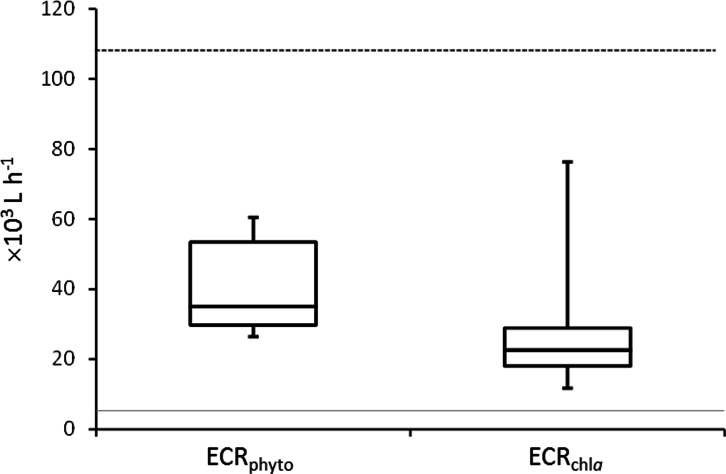
Mussel Effective Clearance Rates (ECR) based on phytoplankton abundance (ECRphyto) decrease and chlorophyll a concentration (ECRchla).The grey line represents the flow rate in the mussel tank (5∗103Lh−1) and the dashed line stands for Population Maximum Filtration Rate (WCRpop) calculated from Riisgård, Larsen & Pleissner (2014) using mussel mean wet weight (modified from Delegrange et al., 2015).